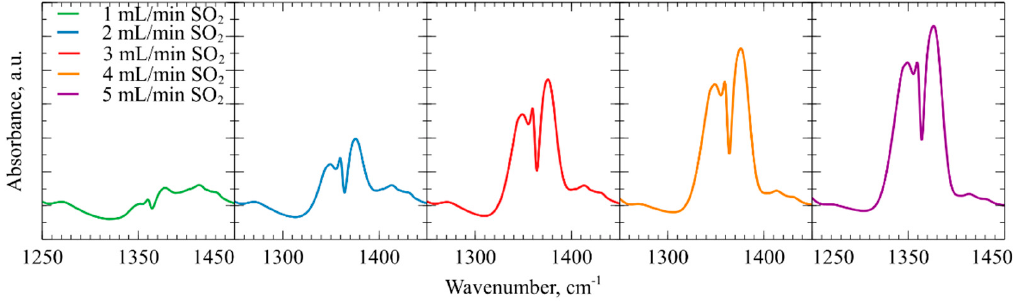
Figure 11. Fourier Transform Infrared spectroscopy data peaks formed at wavenumbers in region 1250 to 1450 cm − 1 produced by absorbance of SO 2 phase molecules.